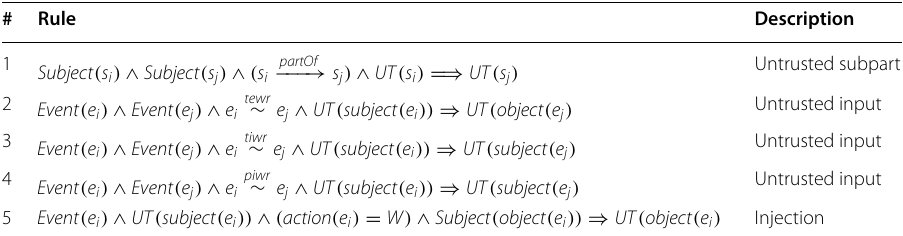
Table 4 Patterns of untrusted subjects rules